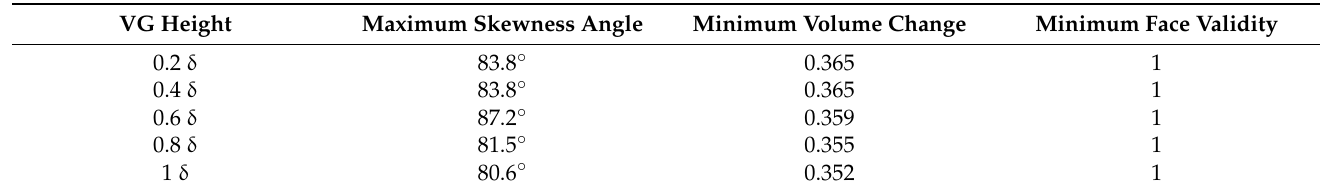
Table 4. Cell quality parameters of the used meshes with the cell-set model. VG